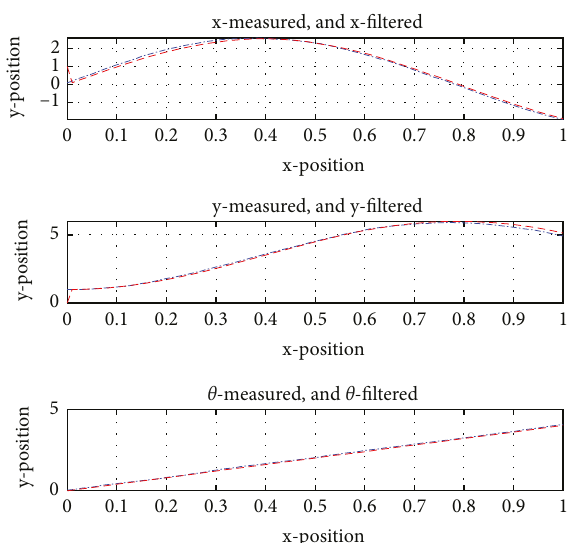
Figure 15: PF performance with one landmark and non-Gaussian noise.